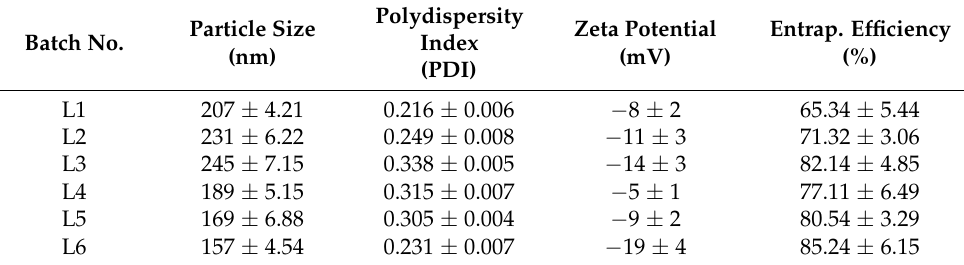
Table 2. Characterization of liposome batches.